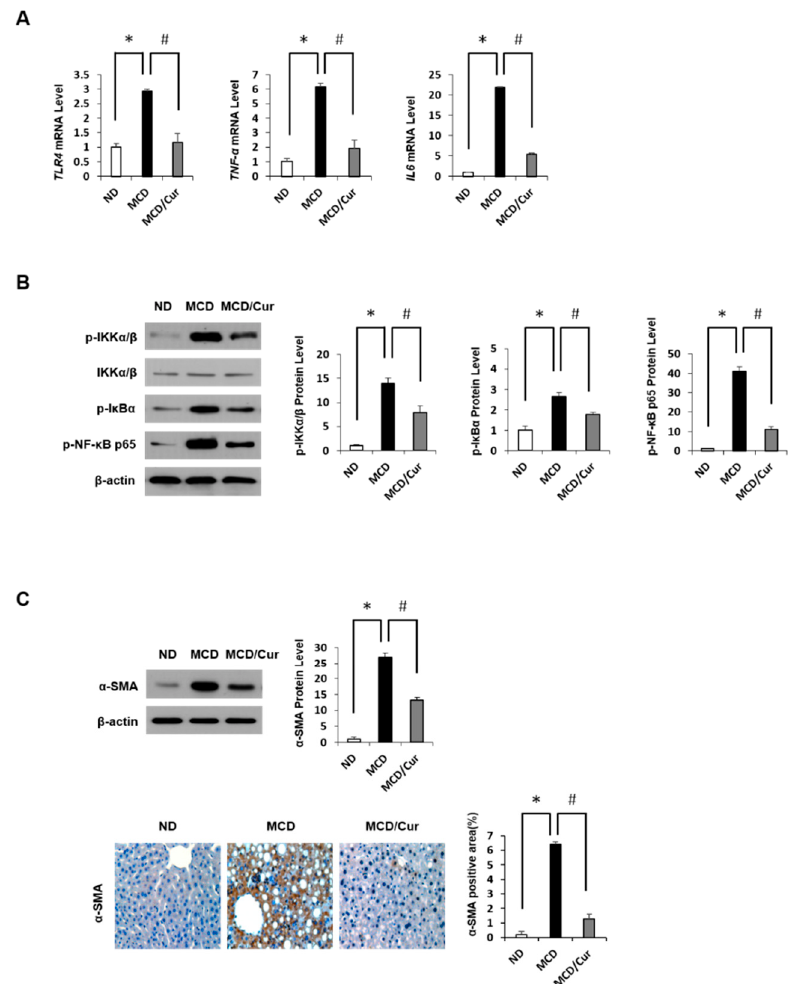
Figure 2. Curcumin modulated the nuclear factor- κ B (NF- κ B) pathway to alleviate inflammation. Liver tissues were prepared from the mice fed ND, MCD diet, or MCD / curcumin (100 mg / kg) diet. ( A ) The mRNA levels of hepatic Toll-like receptor 4 ( TLR4 ), Tumor necrosis factor-alpha ( TNF- α ) and Interleukin 6 ( IL-6 ) were measured by quantitative real-time polymerase chain reaction (qRT-PCR). ( B ) Representative immunoblot analyses of phosphorylated I κ B kinase α / β (p-IKK α / β ), p-I κ B α , and p-NF- κ B p65. ( C ) Liver sections were subjected to immunoblot and IHC analyses (original magnification 200 × ) for α -smooth muscle actin ( α -SMA). Data are mean ± SD ( n = 7 / group). * p < 0.05 vs. ND diet group, and # p < 0.05 vs MCD diet group.